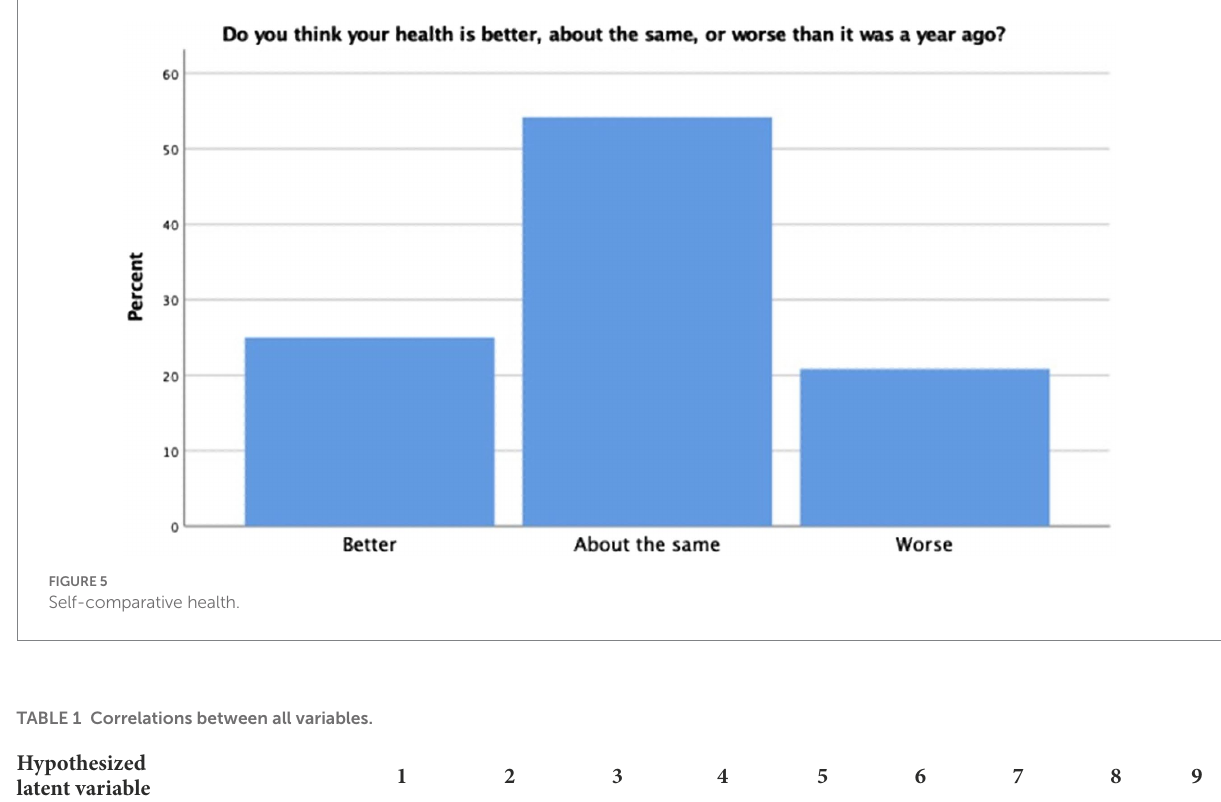
TABLE 1 Correlations between all